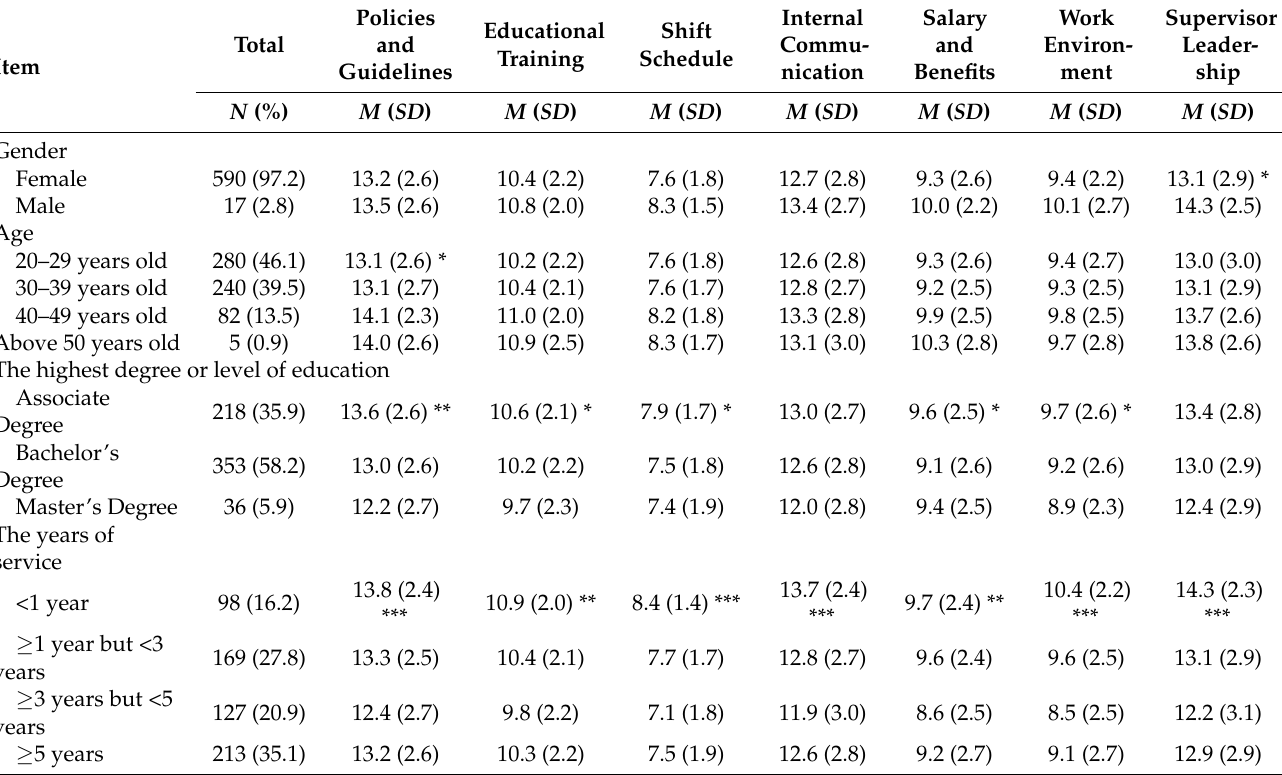
Table 3. Comparison of the nurses’ personal characteristics and scores of the latent variables in the